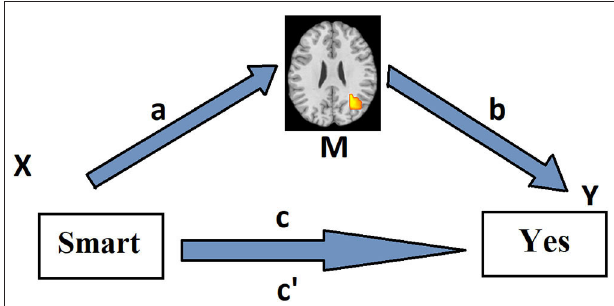
FIGURE 1 | Path model for the first level of the multilevel mediation analysis. Associations between the predictor X (emotional adjective valence) and the mediator M (adjective-presentation-related brain activity) (path a ) and between the mediator M and the dependent variable Y (behavioral choice) (path b ) across the trials are assessed voxel-wise by means of linear regression method in each subject separately. The mediation effect, i.e., the effect of X on Y as mediated by M (path a * b ), is calculated as the product of the resulting two regression coefficients. Path c reflects the total relationship between adjective valence and behavioral response across the trials in a particular subject. Path c reflects this relationship, controlling for activity in a brain